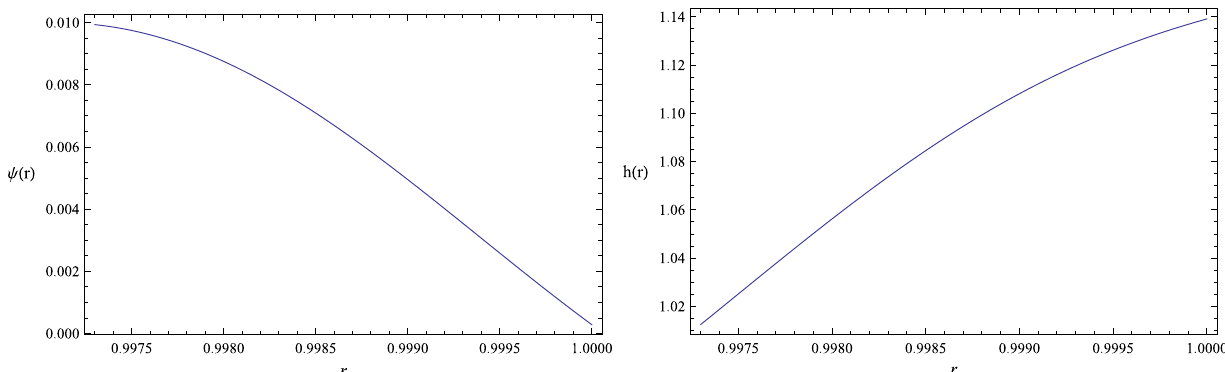
Fig. 1 We plot solutions as a function of the radial coordinate r with q = 100, m 2 = 0, μ = 0 . 15 and ψ( r h ) = 0 . 1. The left panel shows the behaviors of the scalar field ψ( r ) and the right panel is for values of the metric solution h ( r )